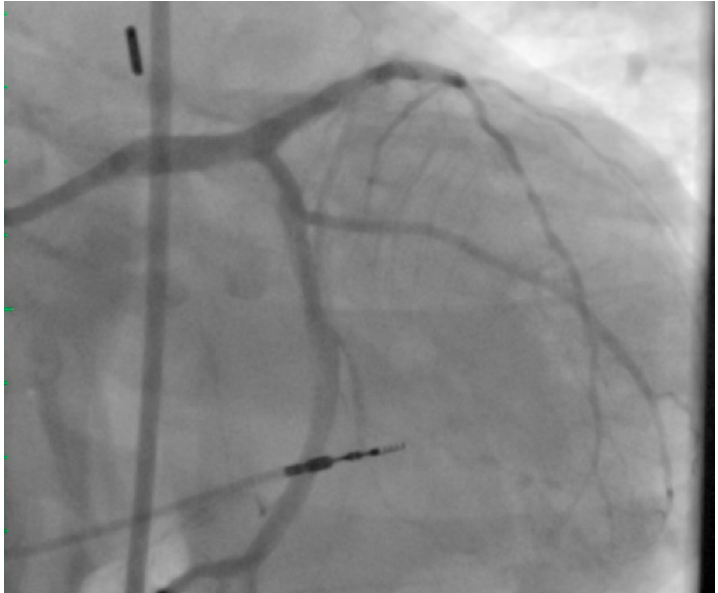
Figure 4. Final Coronary Angiogram. Excellent angiographic result after PCI of the LMCA with a 3.5 × 15 mm Resolute Onyx DES, post-dilated with a 4.0 mm noncompliant balloon. Additionally, PCI of the ostial CFX was completed using a modified T-stent technique with a 3.0 × 15 mm Resolute Onyx DES. Final kissing balloon inflations were performed.